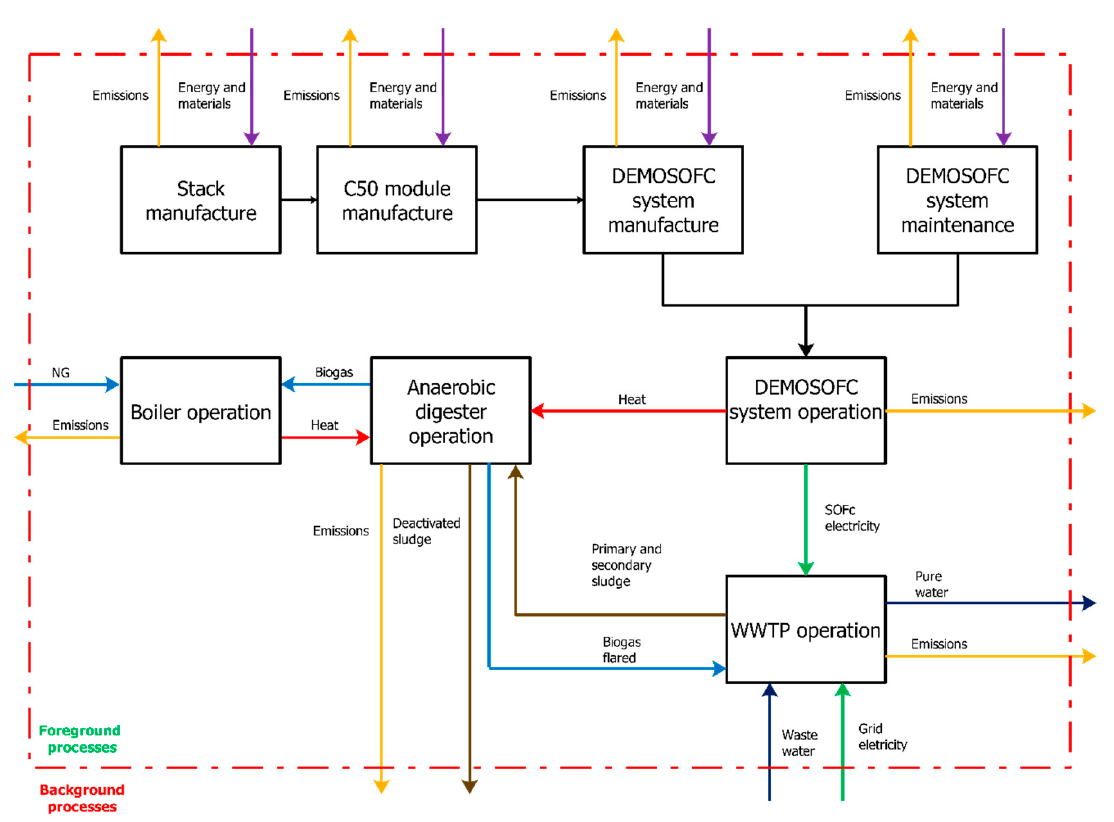
Figure 5. Boundaries of the WWTP with an SOFC-based cogeneration system (Scenarios 2 and 3).